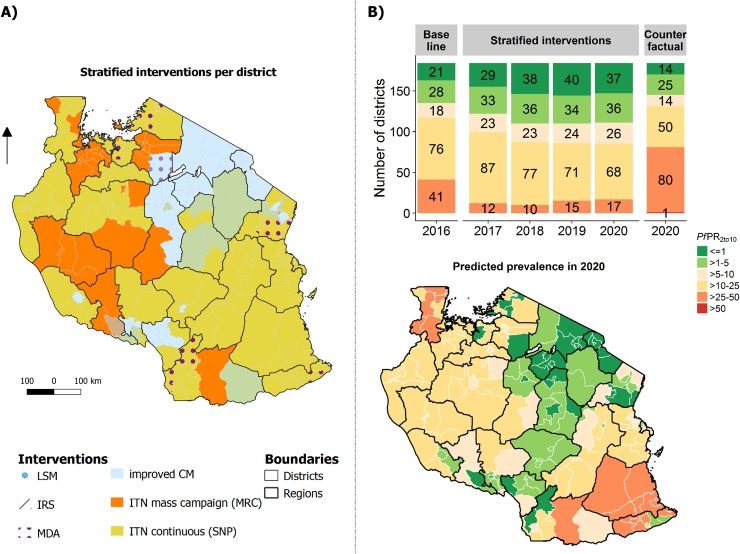
Strategy optimised for cost-effectiveness and simulated impact (Strategy 2).(A) Allocation of interventions per council. (B) Predicted prevalence per council in 2020 shown in the map and number of councils per simulated endemic group for 2017–2020 shown in the bar chart.